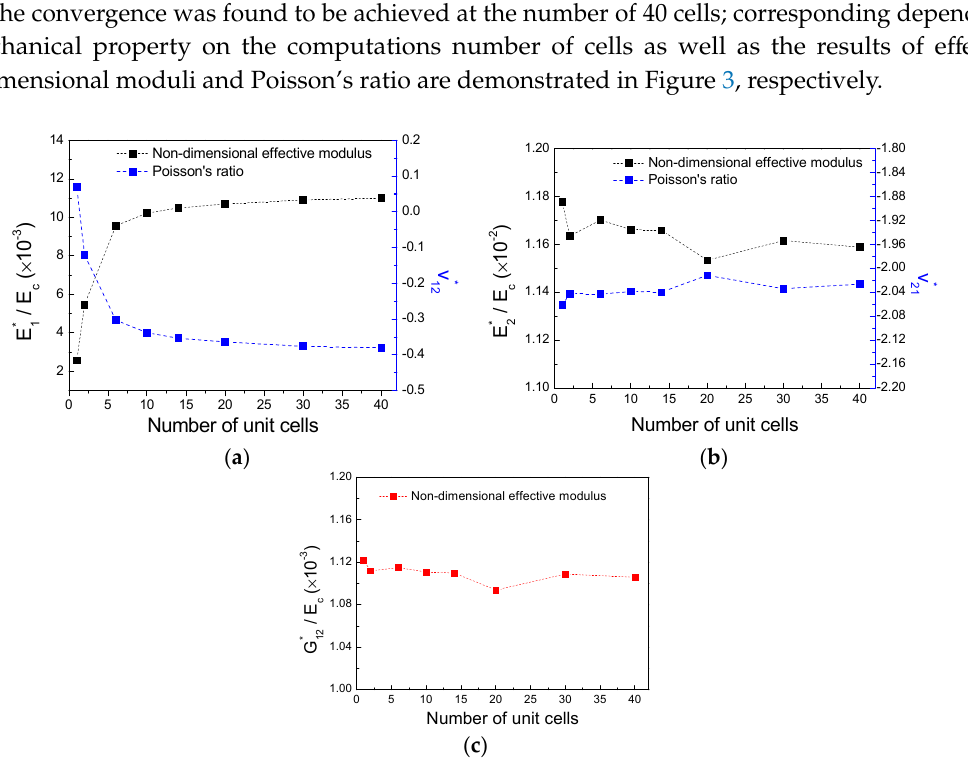
Figure 3. Finite element simulations of effective mechanical property for the new hierarchical metamaterial: ( a ) E ∗ / E c and ν ∗ , ( b ) E ∗ / E c and ν ∗ , ( c ) G ∗ / E c